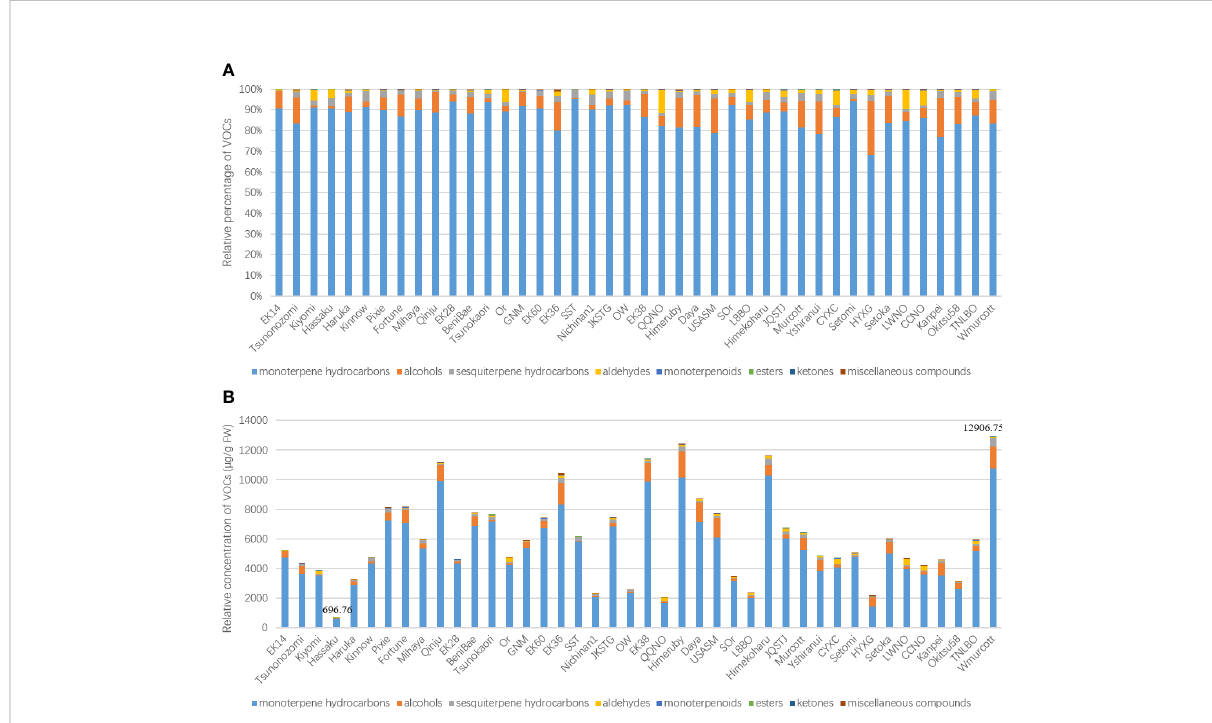
FIGURE 3 Relative percentages of different volatile chemical categories (A) and the relative total concentration of volatile metabolites (B) .